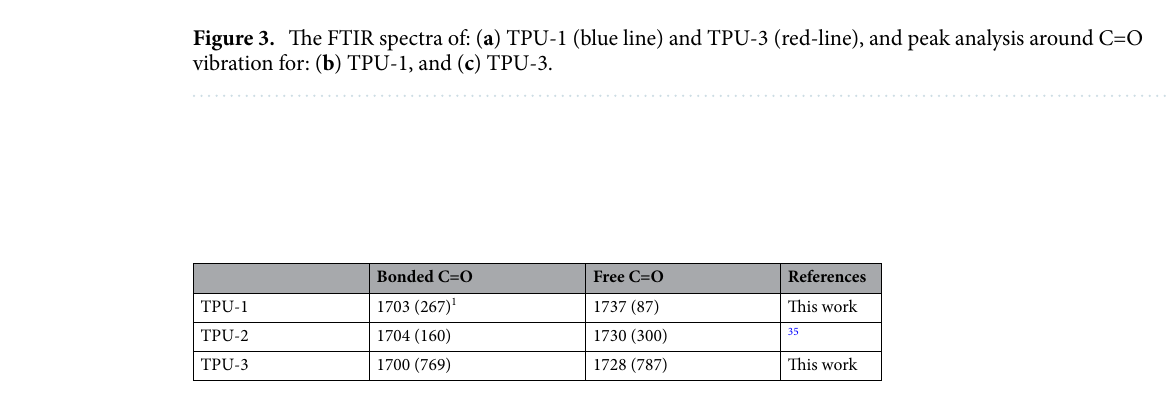
Table 3. The important vibration shifts (cm −1 ) of the FTIR analysis for the TPU. 1 The integral of peaks in cm −1 .